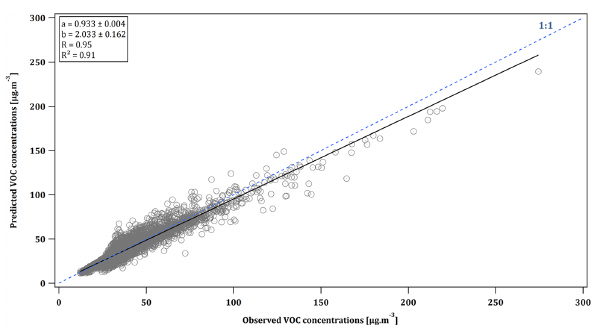
Figure A1. Agreement between total predicted and observed VOC concentrations based on the six-factor PMF